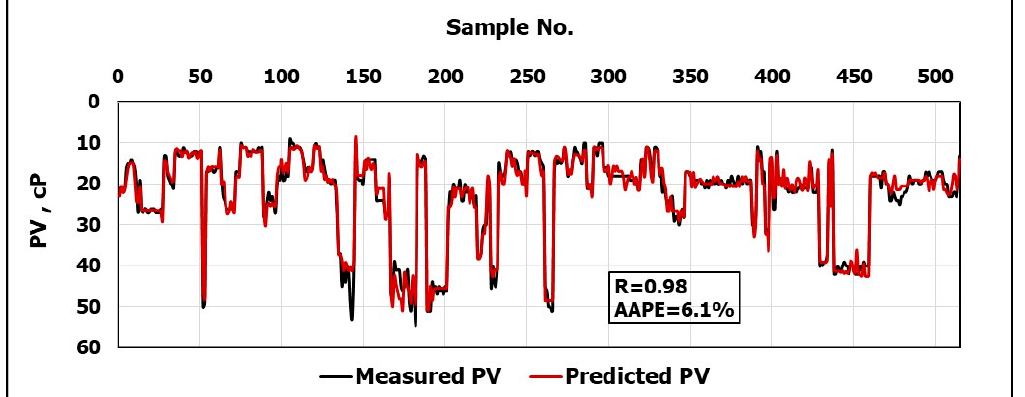
Figure 5. Measured 𝑃𝑉 vs. Predicted 𝑃𝑉 from the ANN model . Figure 5. Measured PV vs. Predicted PV from the ANN